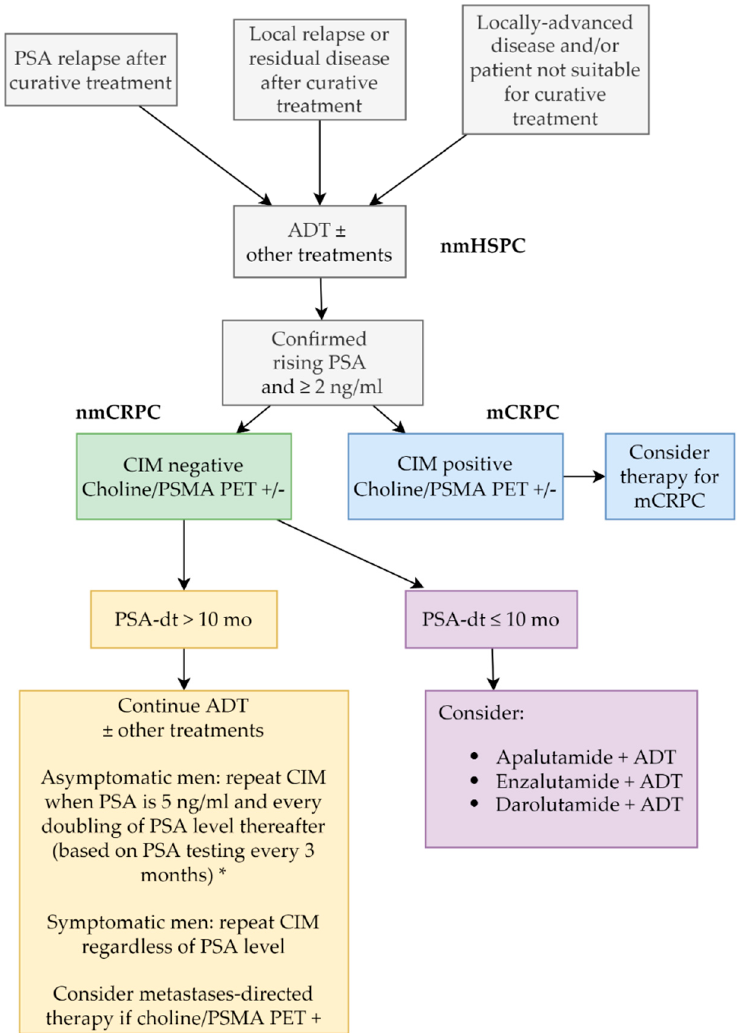
Figure 2. Proposed algorithm of treatment in patients with nmCRPC (this algorithm is a advice from the authors, not a guideline). * Consensus statement by the RADAR group [35] . ADT: androgen-deprivation therapy; CIM: conventional imaging; mCRPC: metastatic castration-resistant prostate